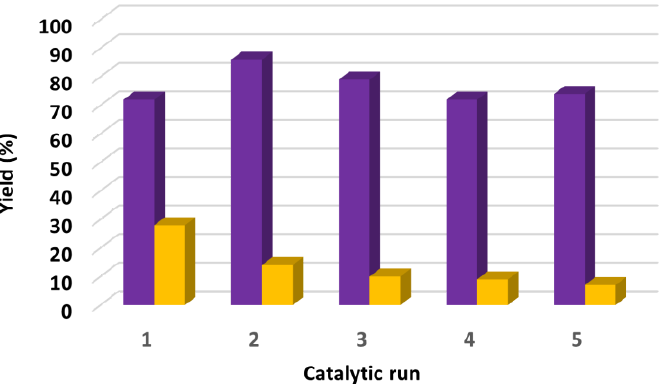
Figure 6. Recyclability of the PTH-material, with yields to each product, sulfoxide (purple) and sulfone (yellow) derived from oxidation of dibutylsulfide.